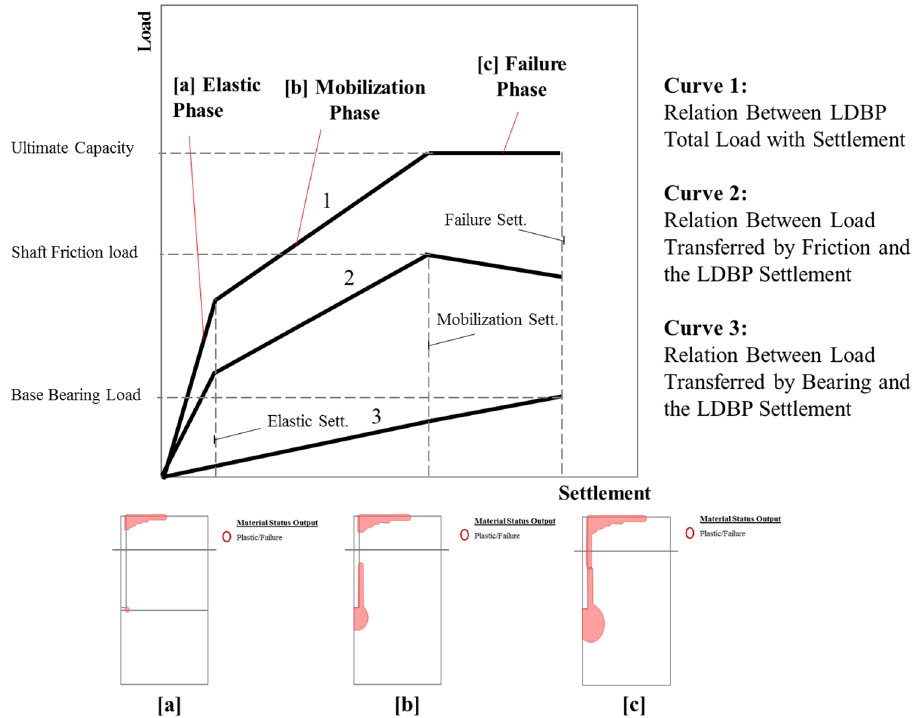
Figure 5. Schematic diagram of three load transfer phases describing the failure mechanism of the